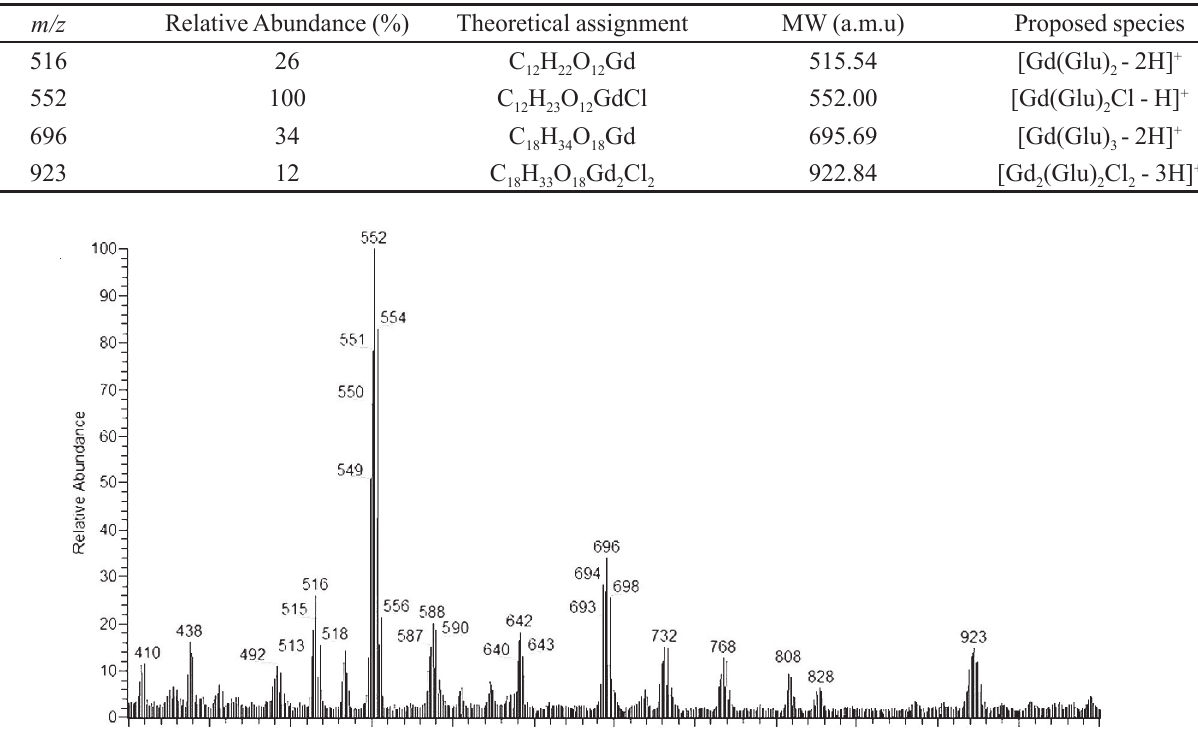
FIGURE 2 - The ESI-MS spectrum of the solutions of Gd-Glu solution, depicting relative abundances as a function of m/z at the 400 to 1100